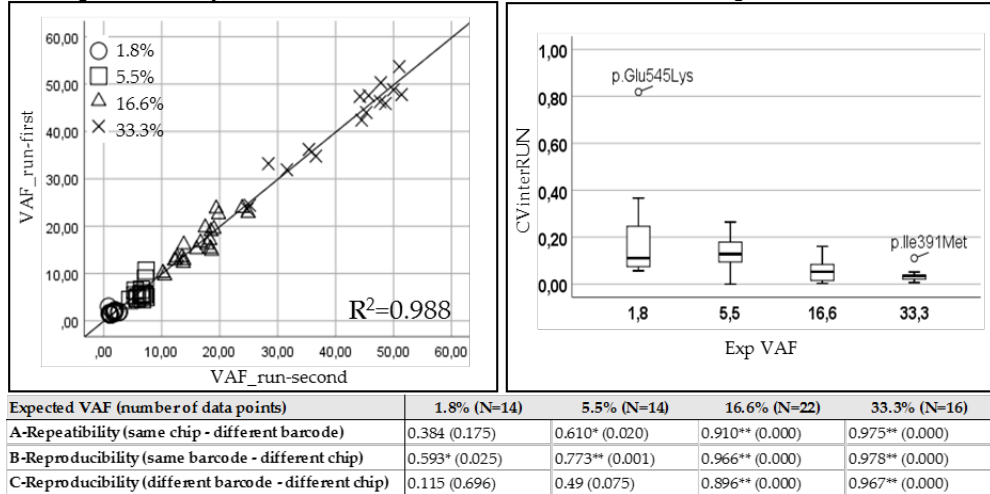
Figure 1. Repeatibility and Reproducibility of the NGS method. Diluted mixed DNA samples from cell lines were analyzed using di ff erent barcodes ( A ) or on di ff erent chips ( B ) or with di ff erent barcodes in two consecutive runs ( C ). Left panels: Each section reports the correlation between the returned VAFs in the specific evaluation experiment. In the scatter graphs, the Pearson’s correlations are illustrated grouping data using di ff erent symbols depending on the expected VAFs. Pearson’s coe ffi cients for each expected VAFs are reported in the table at the bottom of the figure. Significant correlations are flagged with one star (*) or two stars (**) if the p-value is less than 0.05 and 0.001, respectively. Right panels: the box-plots represent the distribution of the coe ffi cients of variation obtained for each experimental condition at di ff erent expected VAFs. Outliers are indicated by the specific mutation